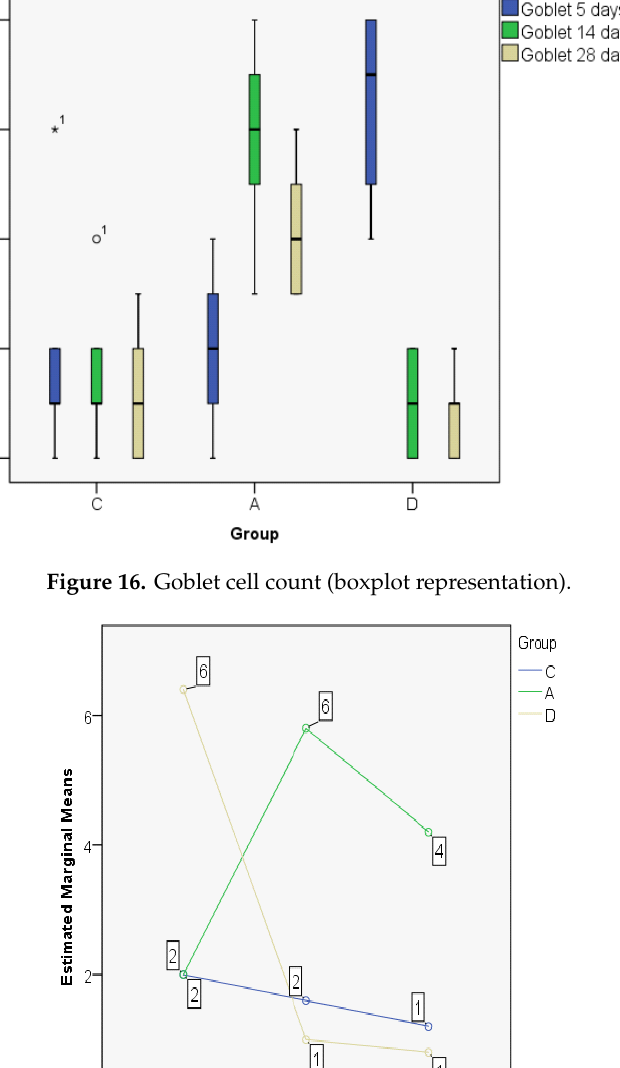
Figure 15. Goblet cell count (median).